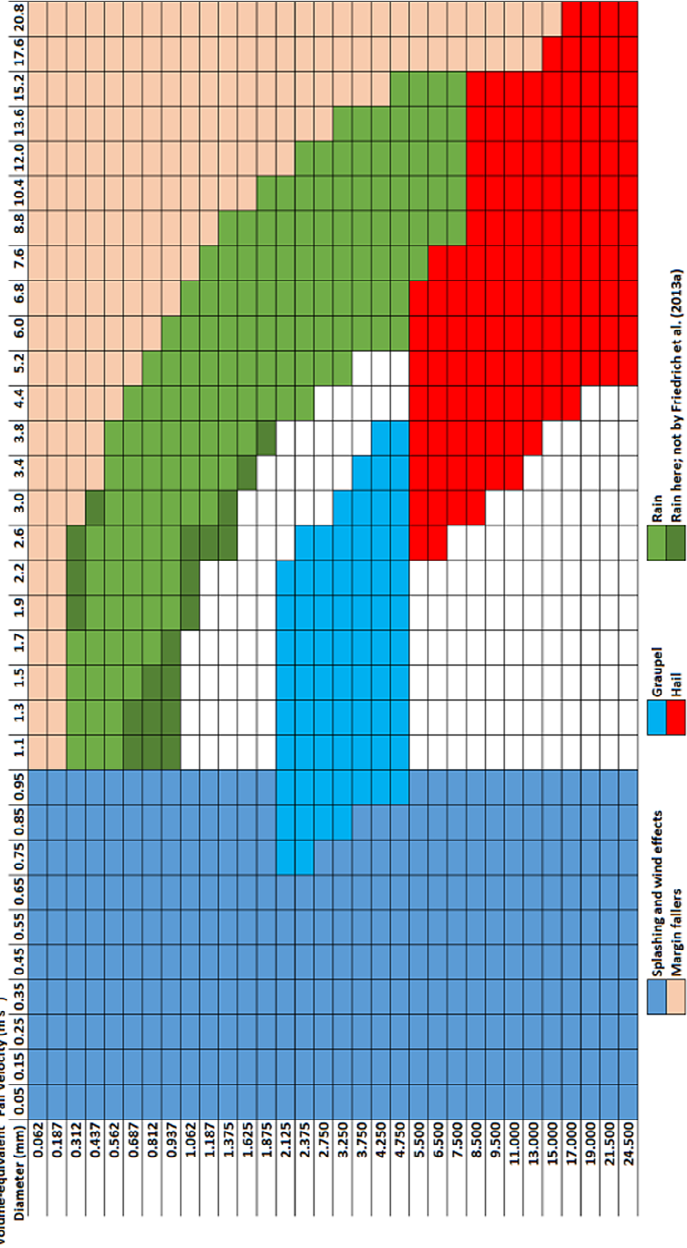
Figure 1. Template used to quality control the disdrometer dataset. Each cell represents one possible combination of drop diameter (left axis; mm) and fall velocity (top axis; m s − 1 ) reported by the PARSIVEL. White cells indicate unrealistic values which are removed if reported. Dark blue and tan cells indicate erroneous data which are also removed if reported. Particles assigned to combinations represented by sky-blue cells are classified as graupel and by red cells as hail. Particles within light green cells are classified as rain in this study and by Friedrich et al. [25], while particles in dark green cells are classified as rain in this study, but not by Friedrich et al. [25]. Z DR data from the WSR-88D were calibrated following the procedure of [29], which is also applied by [17,30]. From the radar dataset, the low-level scan nearest the midpoint of the disdrometer